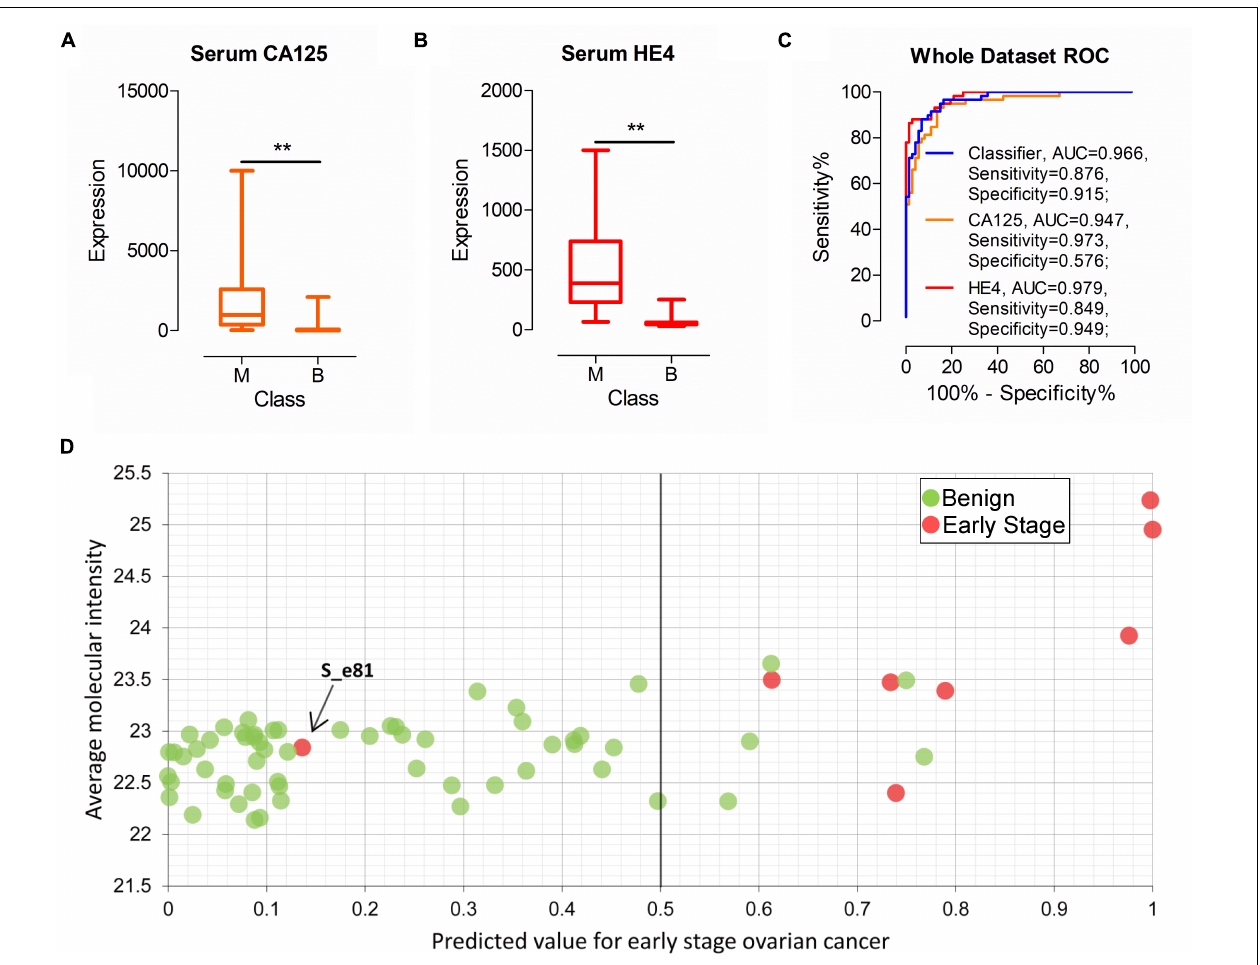
FIGURE 6 | Performance of the classifier, serum CA125 and HE4 in all patients. (A,B) The expression of serum CA125 and HE4 in all patients. (C) ROC analysis of the classifier, serum CA125 and HE4 in all patients. (D) Performance of the classifier in early stage ovarian cancer diagnoses. ** p -value <